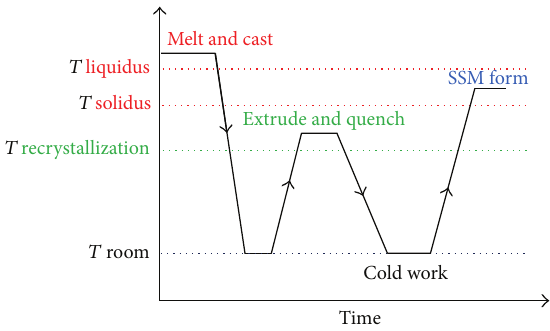
Figure 29: Microstructure of deformed Al 7075 alloy obtained by the SIMA process in the case of being isothermally held for 5min at 620 ∘ C [58].